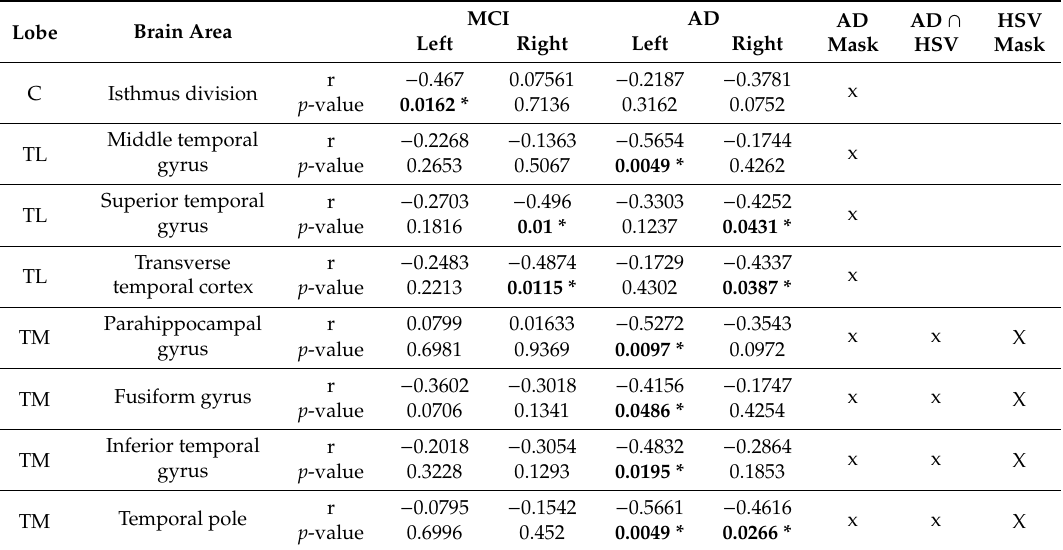
Table 3. Relationship between morphometrical variables and IgG 3